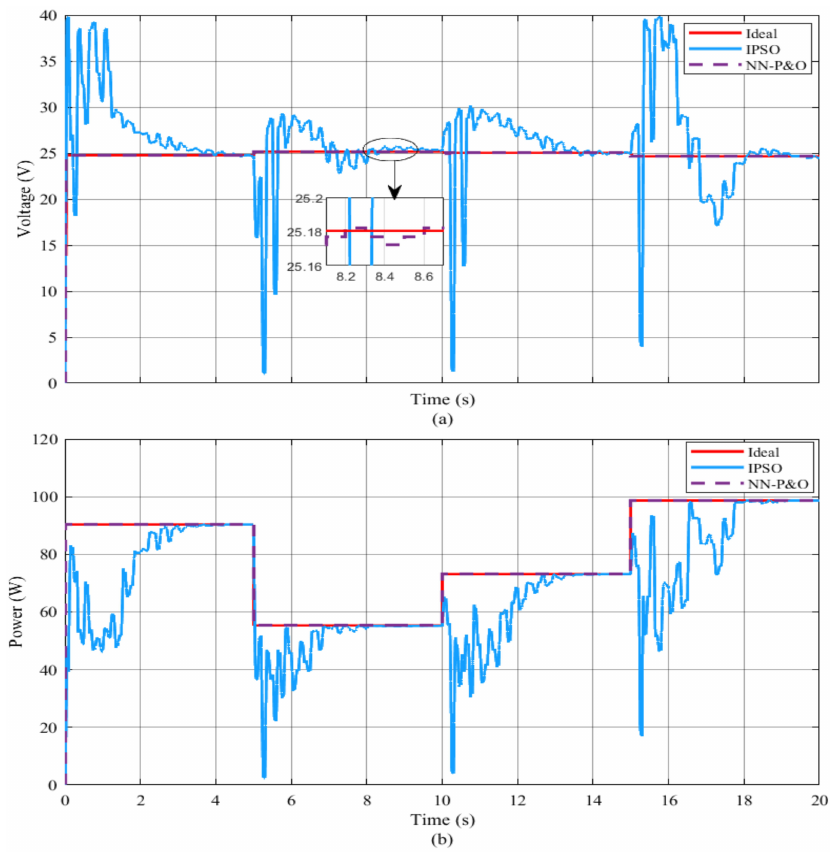
Figure 7. Simulation results under shading by the NN-P&O and IPSO algorithms: ( a ) voltage under shading, and ( b ) power under